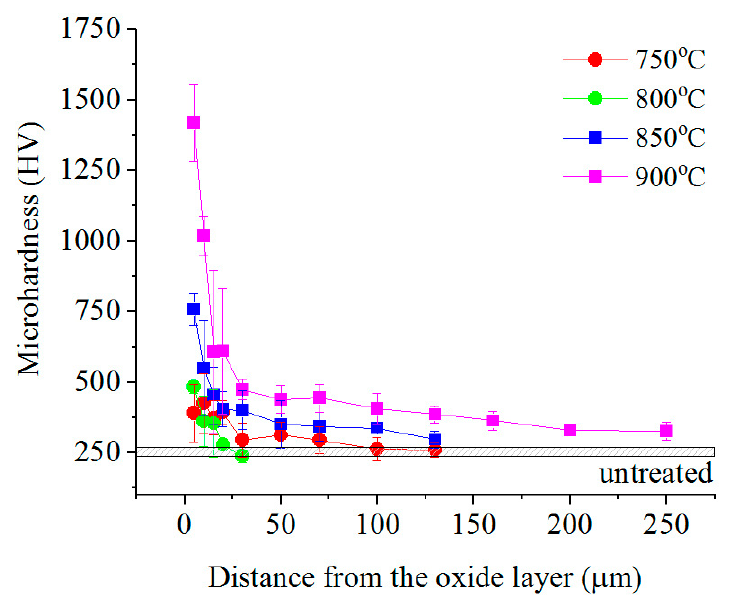
Figure 5. Microhardness distribution in the surface layer after anodic PENC at different treatment temperature.